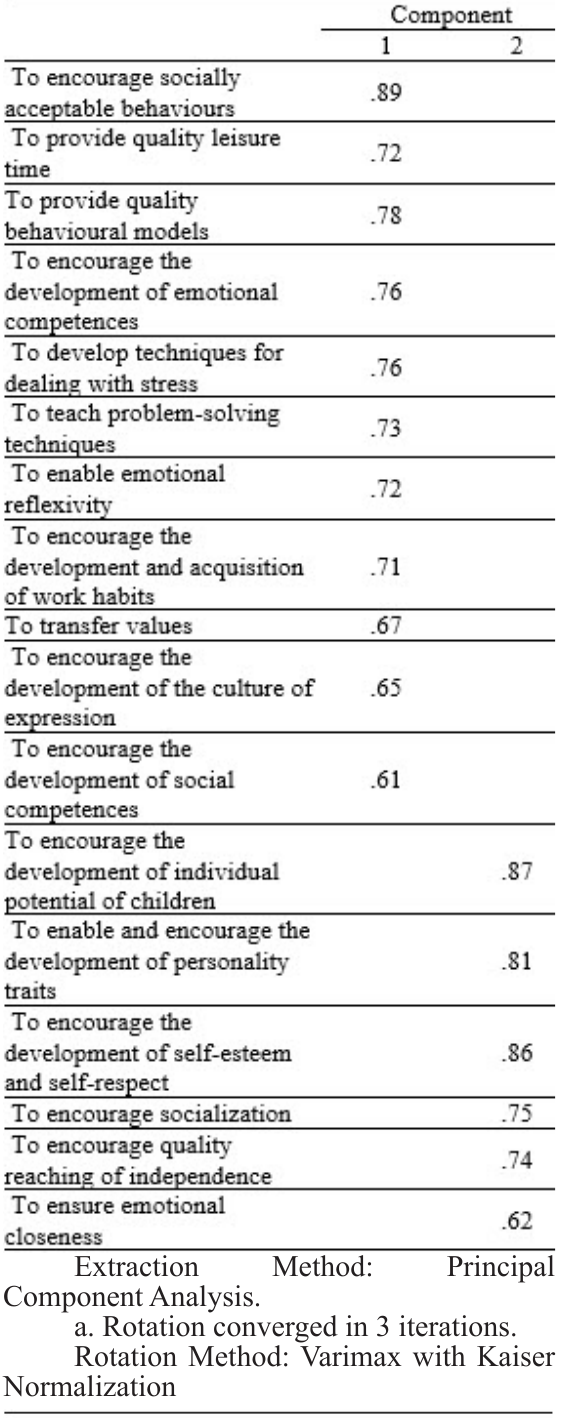
Table 3. Rotated Component